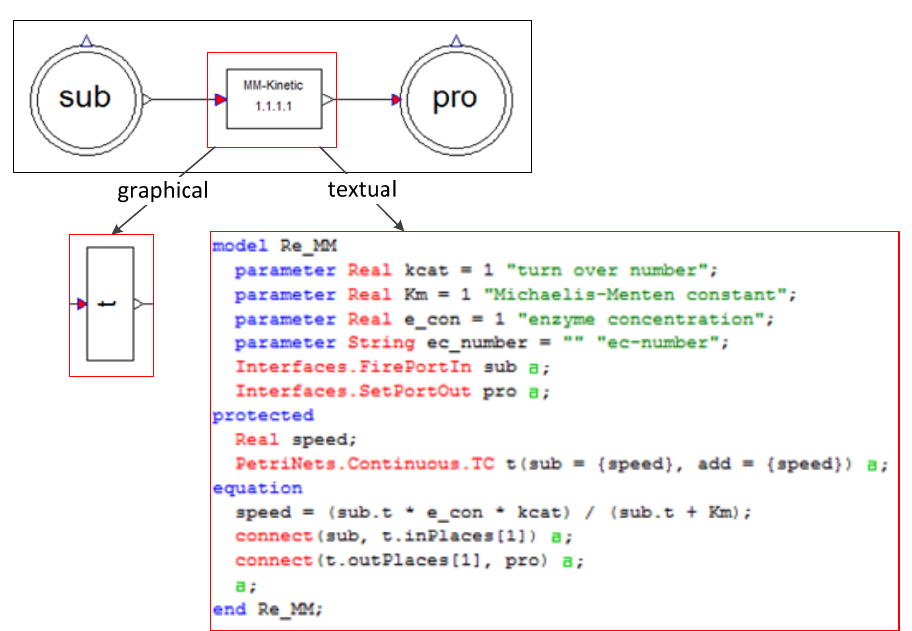
Figure 13: Wrapper of the Michaelis-Menten